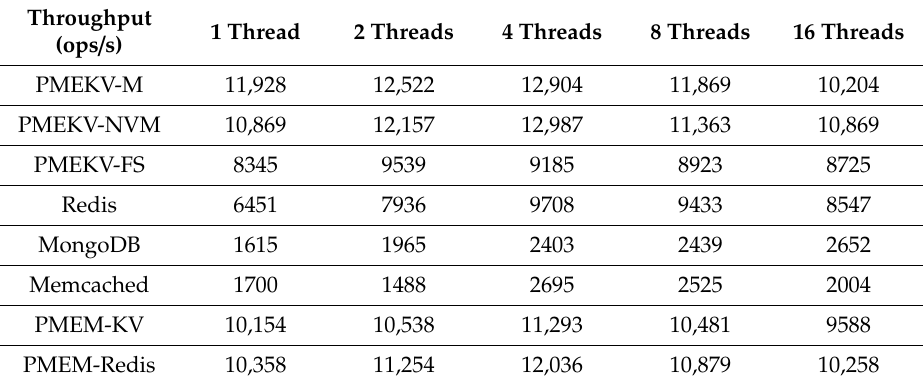
Table 4. The results of changing the number of threads on